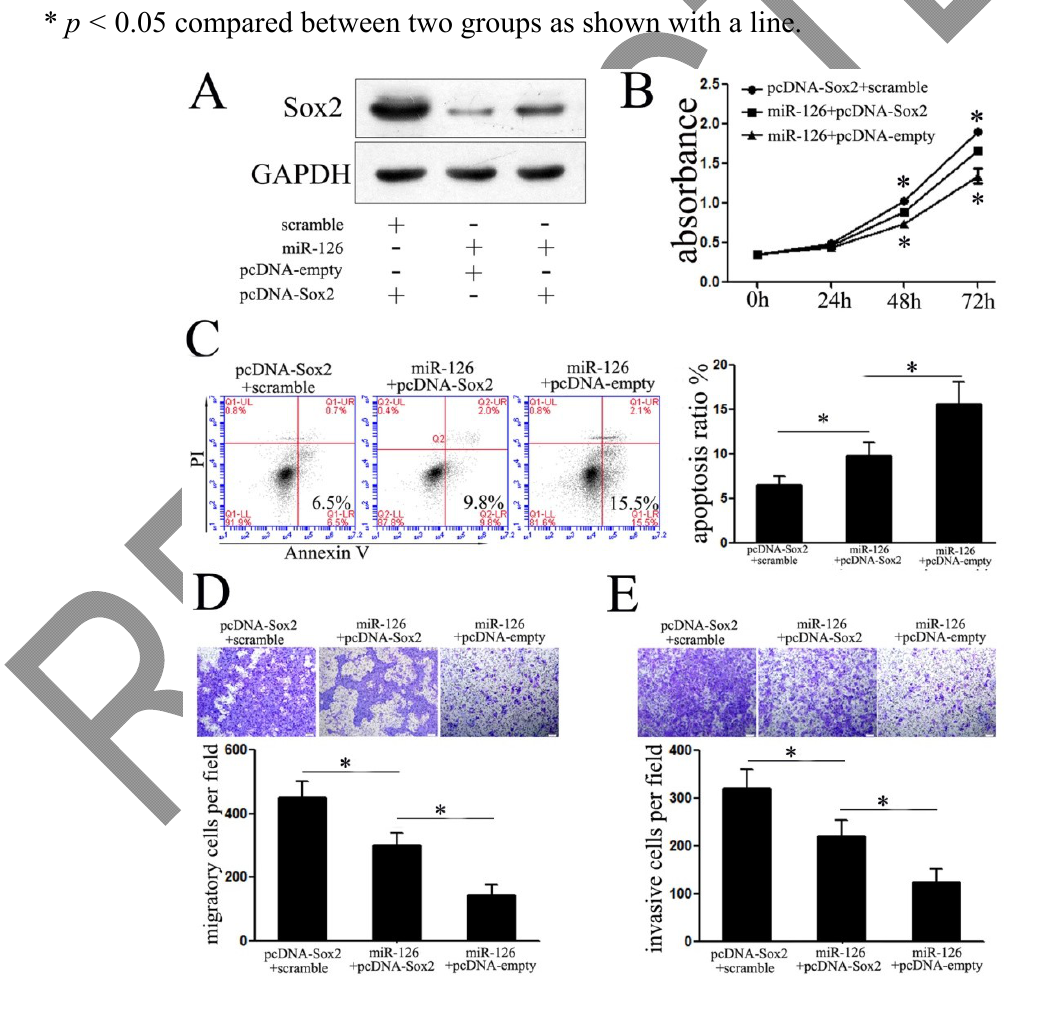
Figure 4. miR-126 suppresses tumor progression through targeting Sox2. ( A ) Upon transfection with Sox2 construct, we rescued the expression of Sox2 in MG-63 cells. The expression of Sox2 protein was validated by western blot assays; ( B ) CCK-8 assays were used to detect in MG-63 cells co-transfected with miR-126 mimic and pcDNA-Sox2 plasmid; ( C ) Cell apoptosis of MG-63 cells treated as described in B was detected by Annexin V-PE staining; and ( D , E ) Transwell assays were performed to detect the effects on cell migration and invasion of MG-63 cells treated as described in B. Upon transfection with the Sox2 plasmid, miR-126-mediated suppression of cell proliferation, cell migration and invasion was abolished, and promotion of cell apoptosis was inhibited. (×100); * p < 0.05 compared between two groups as shown with a